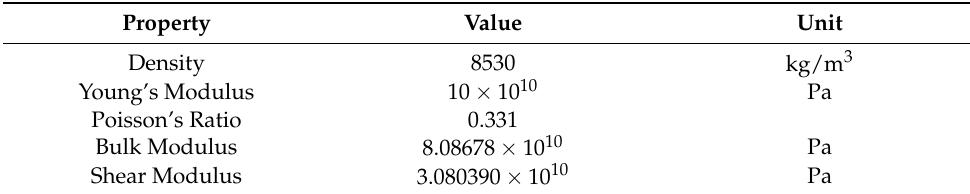
Table 2. Ansys 70/30 [Cu/Zn] brass material properties.